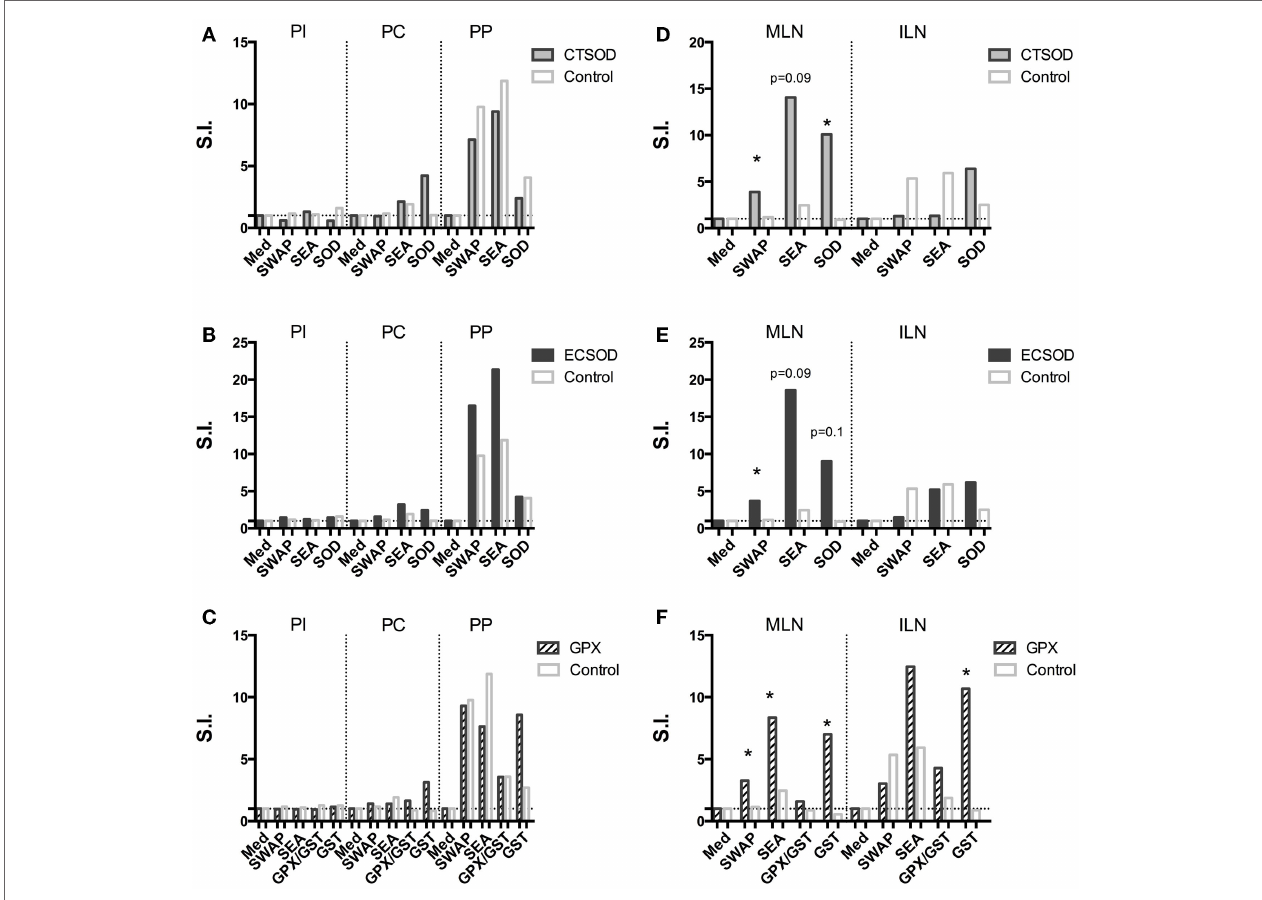
point (PP). Results were expressed as Stimulation Index (S.I.), the ratio of the mean counts per minute (cpm) of triplicate culture cells taken up in the presence of the antigen over those obtained with medium alone. Non- parametric (Kruskal–Wallis, Mann–Whitney) tests were applied. Values were considered statistically significant when p <